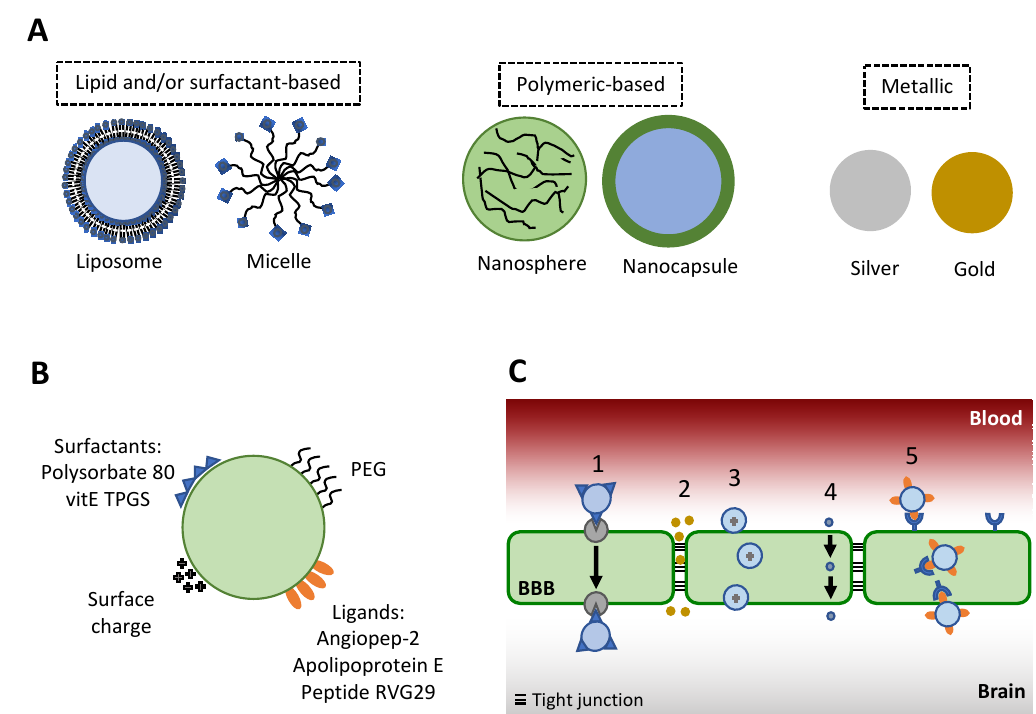
Figure 2. Schematic representation of nanocarriers, their surface modification and possible routes of transport across the blood–brain barrier (BBB). ( A ) Nanocarriers frequently employed for drug delivery to the central nervous system. ( B ) Examples of nanocarrier surface modification to improve passage through the BBB; ( C ) Possible routes of nanocarrier-mediated transport across the BBB. 1 —Nanocarrier-mediated transport; 2 —Paracellular pathway, which can result from the ability of a nanocarrier and / or its components to open tight junctions; 3 —Adsorption-mediated transcytosis; 4 —Transcellular pathway, which might result from the ability of nanocarrier components to improve membrane permeability; 5 —Receptor-mediated transcytosis. PEG: polyethyleneglycol; vitE TPGS: D- α-tocopherol polyethylene glycol 1000 succinate.